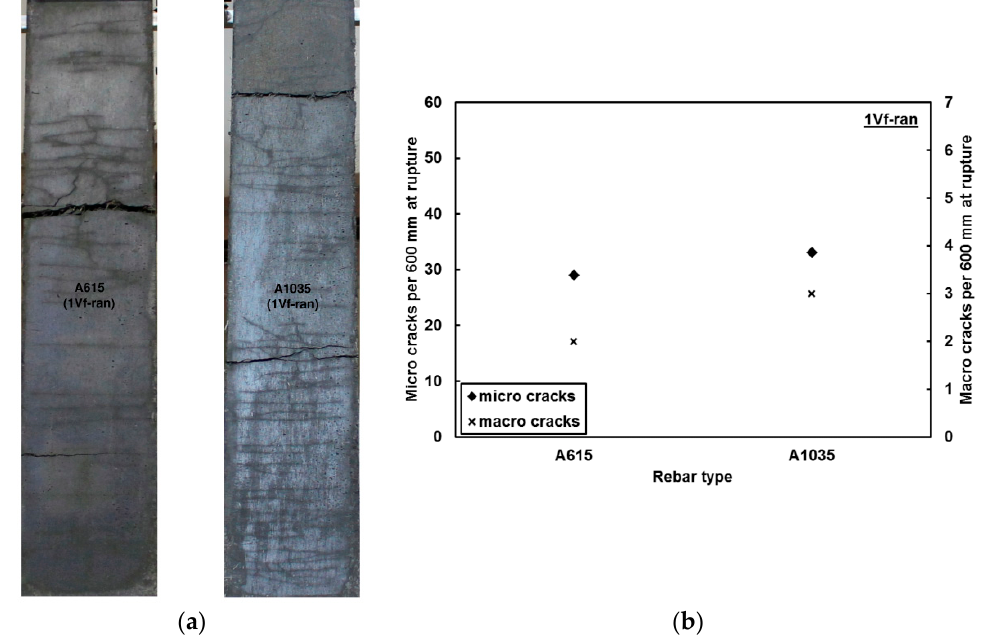
Figure 22. Failure patterns w.r.t. rebar type (specimens with 1% fiber volume fraction and random fiber orientation): ( a ) Failure patterns; ( b ) Number of cracks.